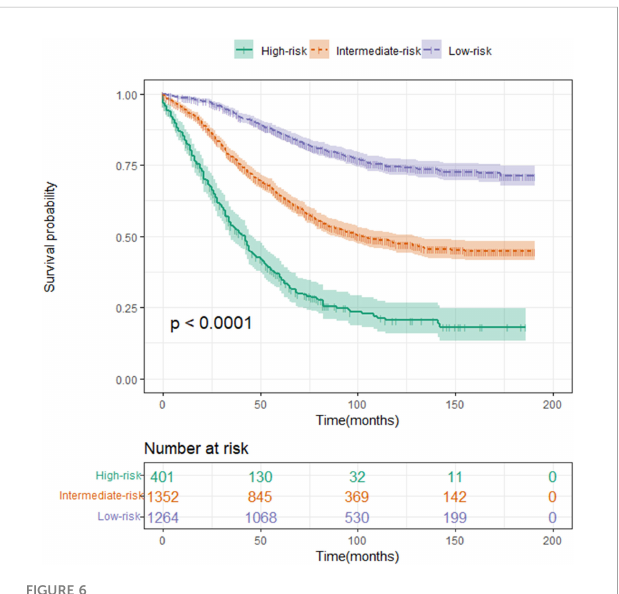
FIGURE 6 Kaplan – Meier curve of CSS for risk classi fi cation based on the nomogram scores in the development cohort. Low-risk group (score<143.54); intermediate-risk group (score=143.54 – 214.75); and high-risk group (score